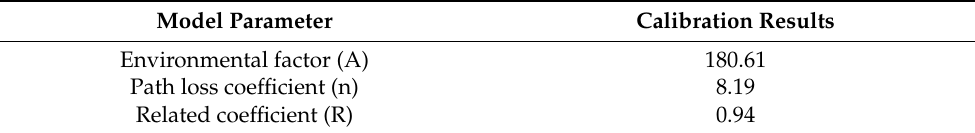
Table 1. Model fitting formula-related